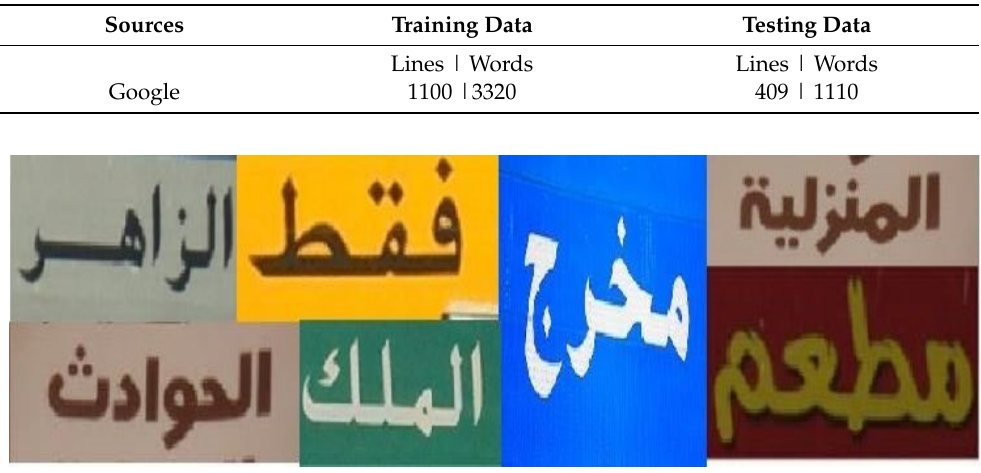
Figure 5. Sample images from one word dataset.